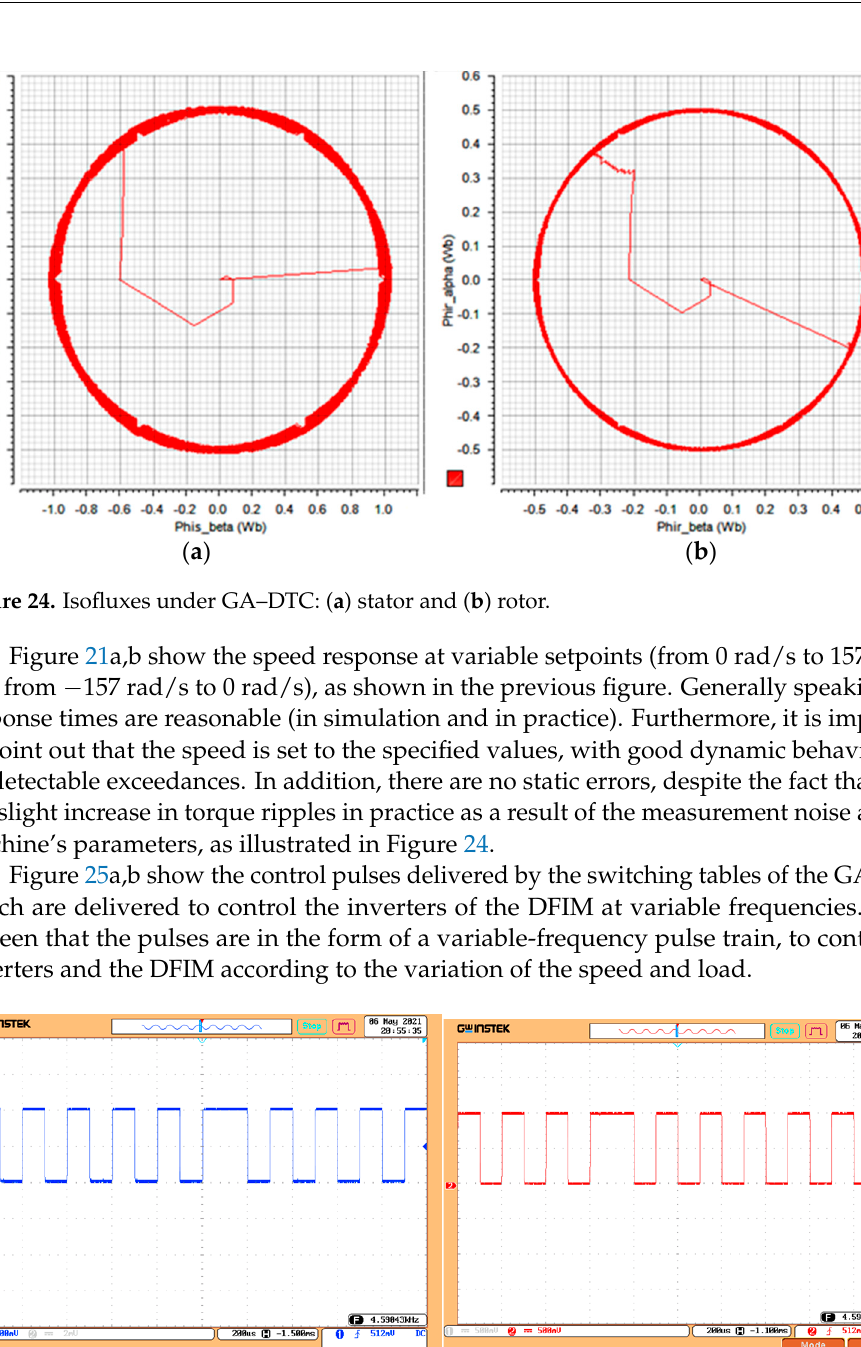
Figure 23. Stator currents of the GA–DTC; ( a , b ) zooms of currents from 0.9 s to 1.2 s and from 1.9 s to 2.2 s, respectively.